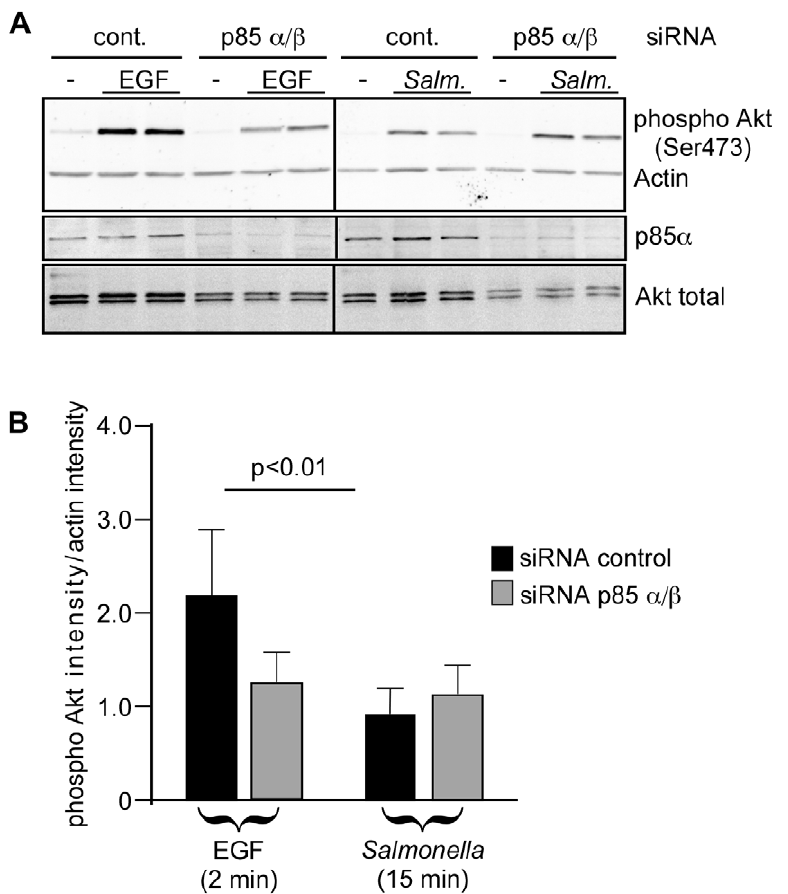
Figure 2. The class I PI3K regulatory subunits p85 a and p85ß are not required for SopB-mediated Akt phosphorylation. HeLa cells were transfected with siRNAs, specific for p85 a and p85ß, for 72 hr then either treated with EGF or infected with Salmonella WT. For siRNA control siRNA specific for AKT3 was used (cont.). Monolayers were then solubilized in sample buffer and processed for immunoblotting using antibodies to detect phospho Akt (Ser473), total Akt or p85 a . (A) Representative immunoblot showing p85 a knockdown efficiacy and effect on Akt phosphorylation in infected or EGF treated cells. (B) Quantification of Akt phosphorylation estimated by densitometry. Shown are the means 6 SD from three independent